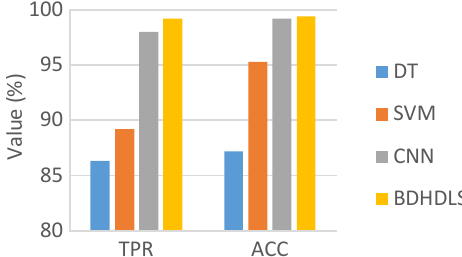
Fig. 15 TPR and ACC for DARPA1998 dataset.